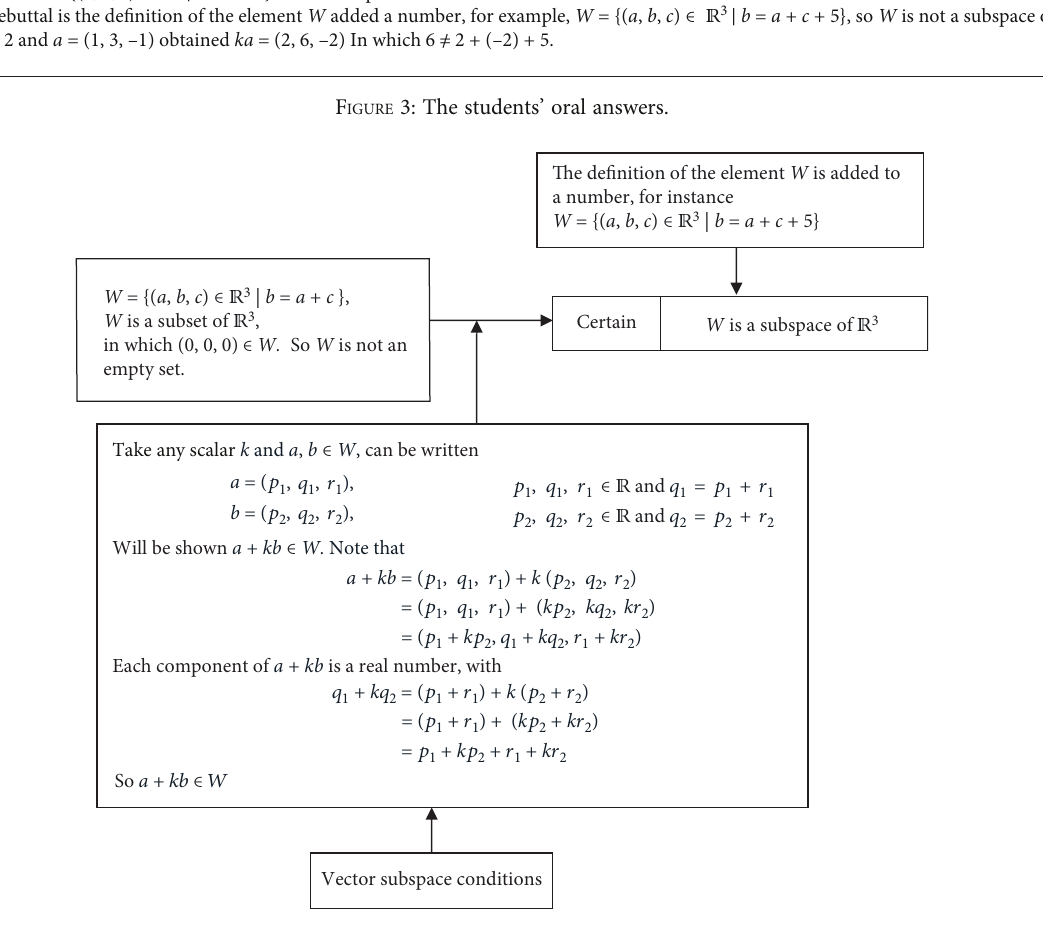
F IGURE 4: Student mathematical argumentation